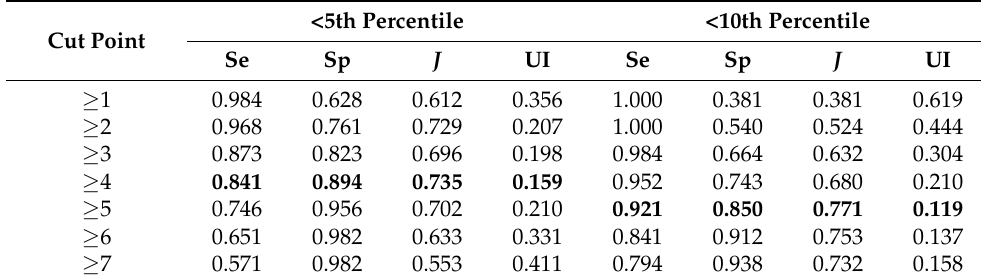
Table 4. Cut point and associated sensitivity and specificity